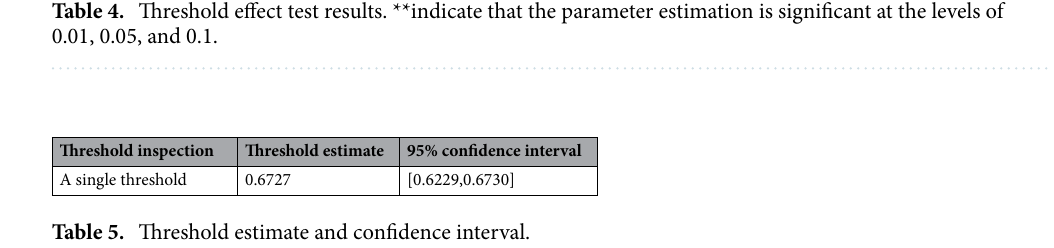
Table 5. Threshold estimate and confidence